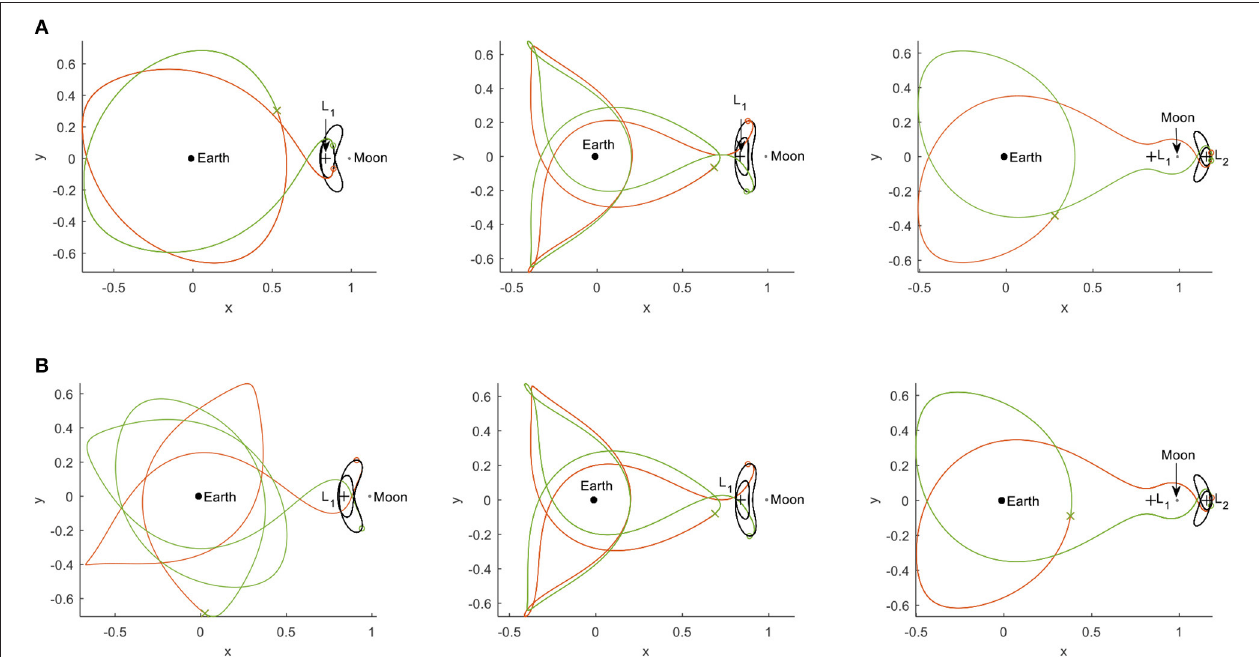
FIGURE 11 | Best homoclinic connections (FLTR: transfers 1–3). (A) For opposite-sign pitch angles. (B) For genetic algorithm approach.